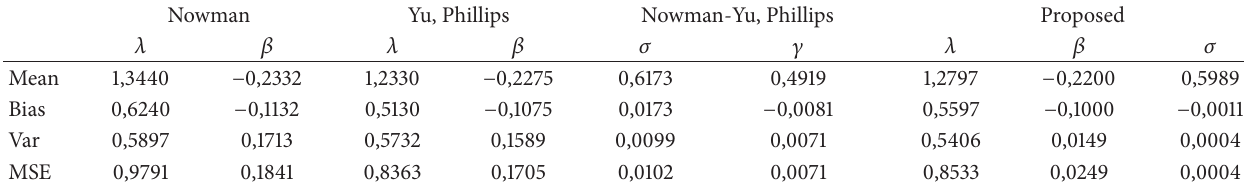
Table 3: Comparison of monthly data series with Nowman, Yu-Phillips, and proposed methods.